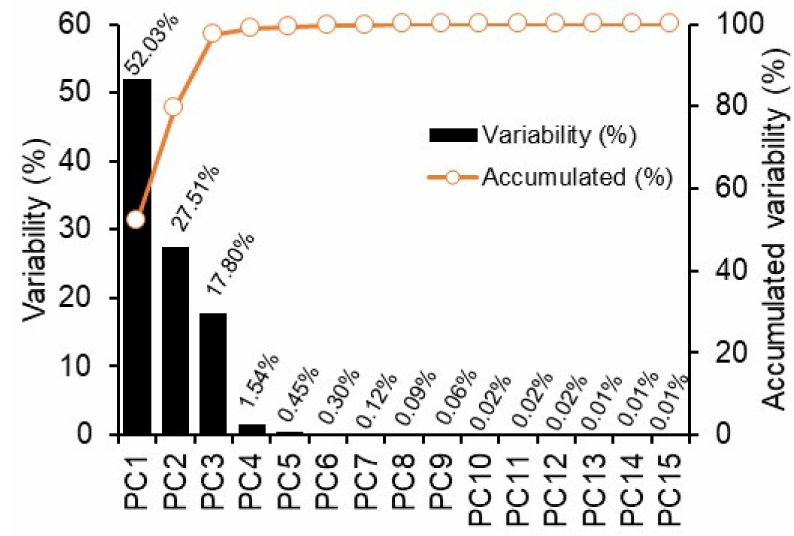
Figure 2. Principal component analysis (PCA) and PC scores obtained from hyperspectral anal- ysis of the tobacco plants. Black bars indicate variability of PC, and orange circles indicate accumulated variability. Table 2. Statistical metrics obtained by the PLSR model in calibration and cross-validation. Maximum number of components used (factors PLS), model goodness-of-fit (R 2 ), offset, root mean square error (RMSE) and ratio of performance to deviation (RPD) for calibration (Cal) and cross-validation (Cva) data generated using 260 random permutations of the data with 70% used for Cal and 30% used for Val for the PLSR models predicting parameters of yield, calorimetry and chlorophyll a fluorescence parameters from hyperspectral of tobacco leaves. Bias outputs are not shown, as they were always lower than 0.01 for both Cal and Cva. Parameter abbreviations—see Table 1. The bold represents statistically significant regression models (R 2 ). The underline indicates a bad residual prediction deviation (RPD) was calculated.